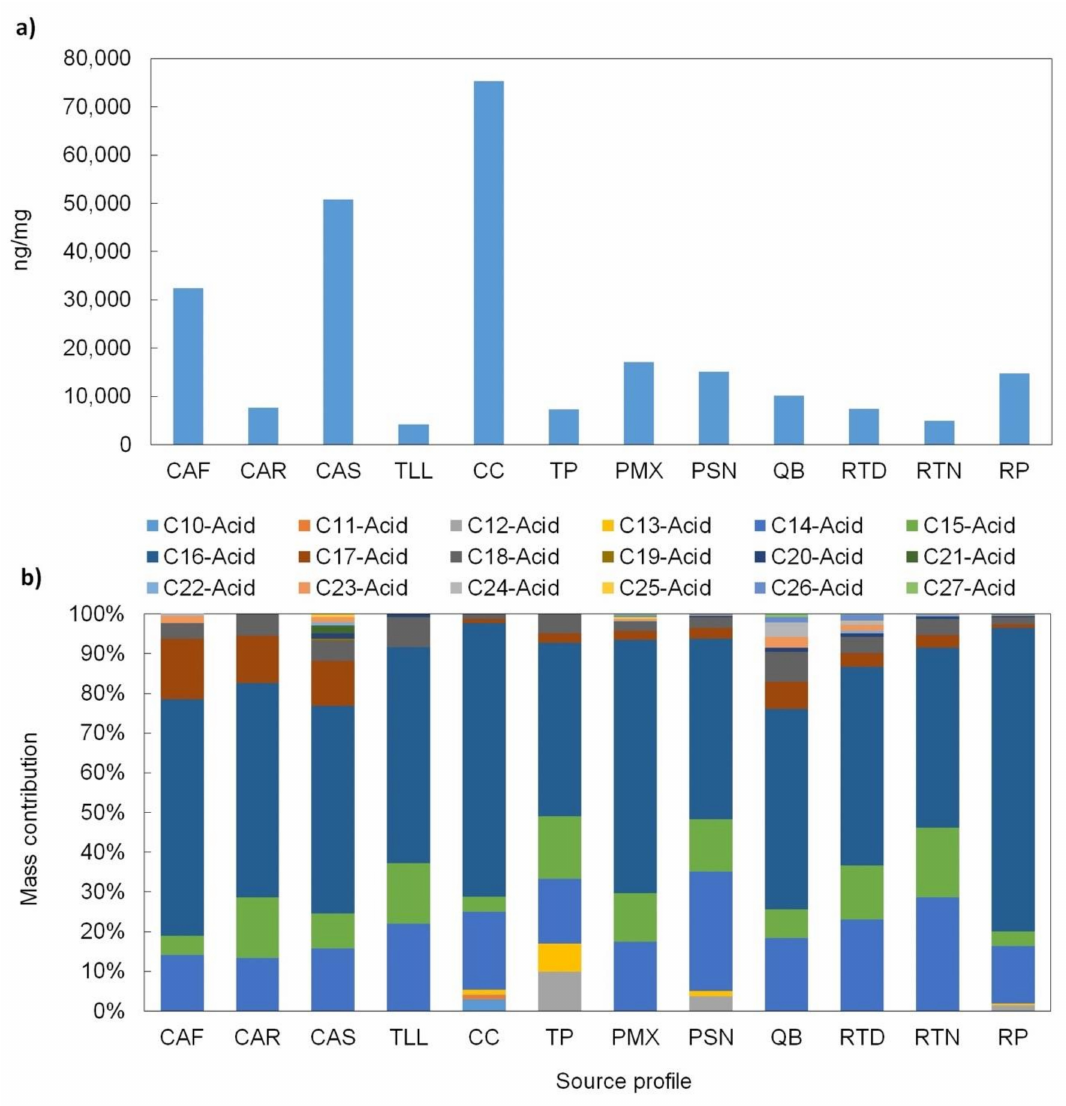
Figure 8. ( a ) n -alkanoic acids total concentration and ( b ) mass contribution of individual n -alkanoic acids to the total n -alkanoic acids EOM for each source profile. Definition of source profile codes are presented in Table